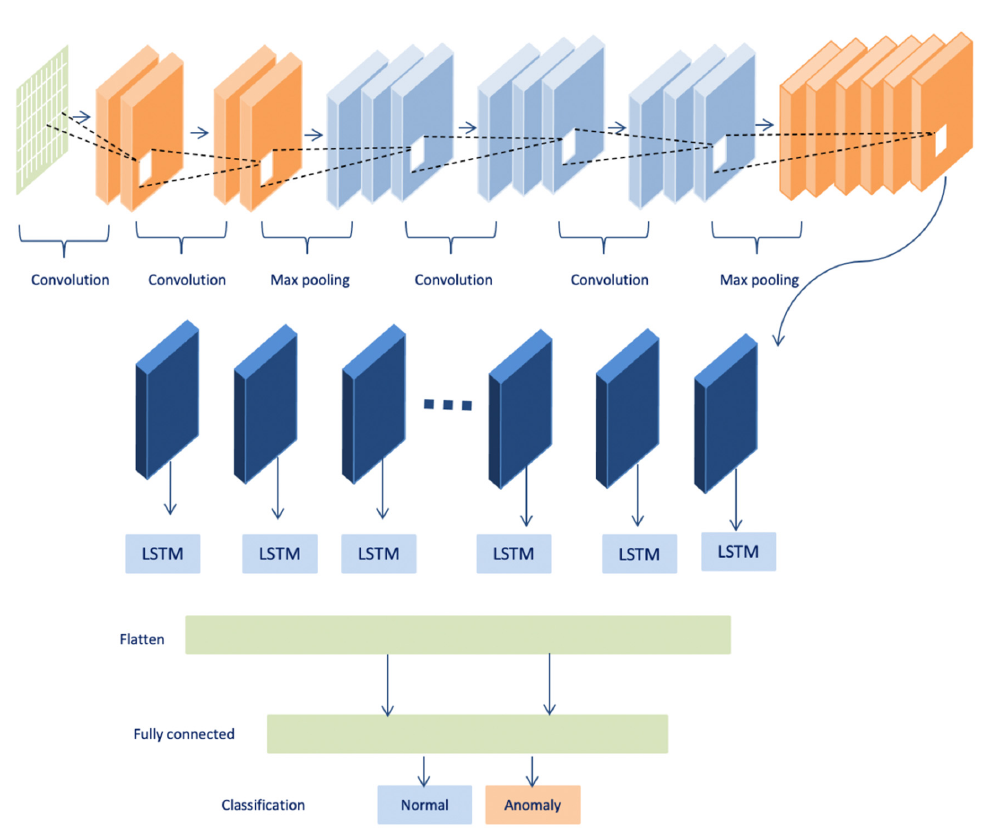
Figure 4. CNN-LSTM (ConvLSTM) Figure 4. CNN ‐ LSTM (ConvLSTM) Architecture.